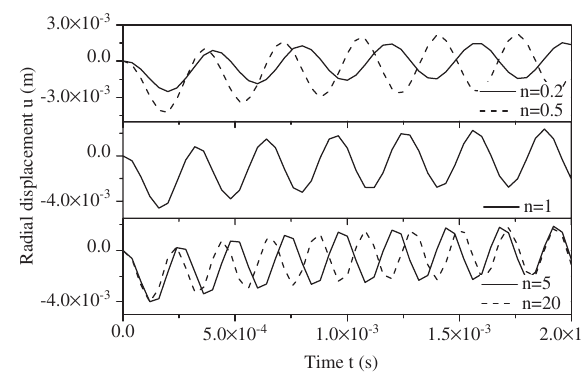
Figure 11 Response histories of radial displacement in the FGM hollow cylinder with different n , where r = 0.375